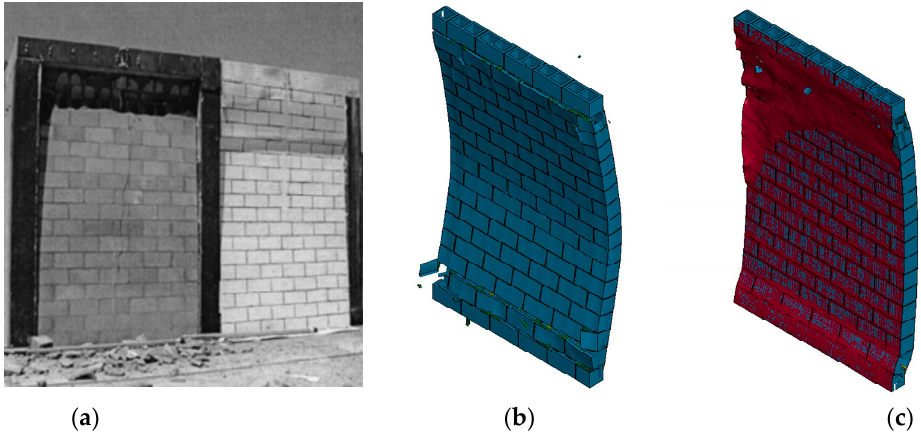
Figure 11. Damage of SPUA-retrofitted wall: ( a ) test results; ( b ) 6.35 mm SPUA-retrofitted; ( c ) double-layer 3.125 mm SPUA-retrofitted.